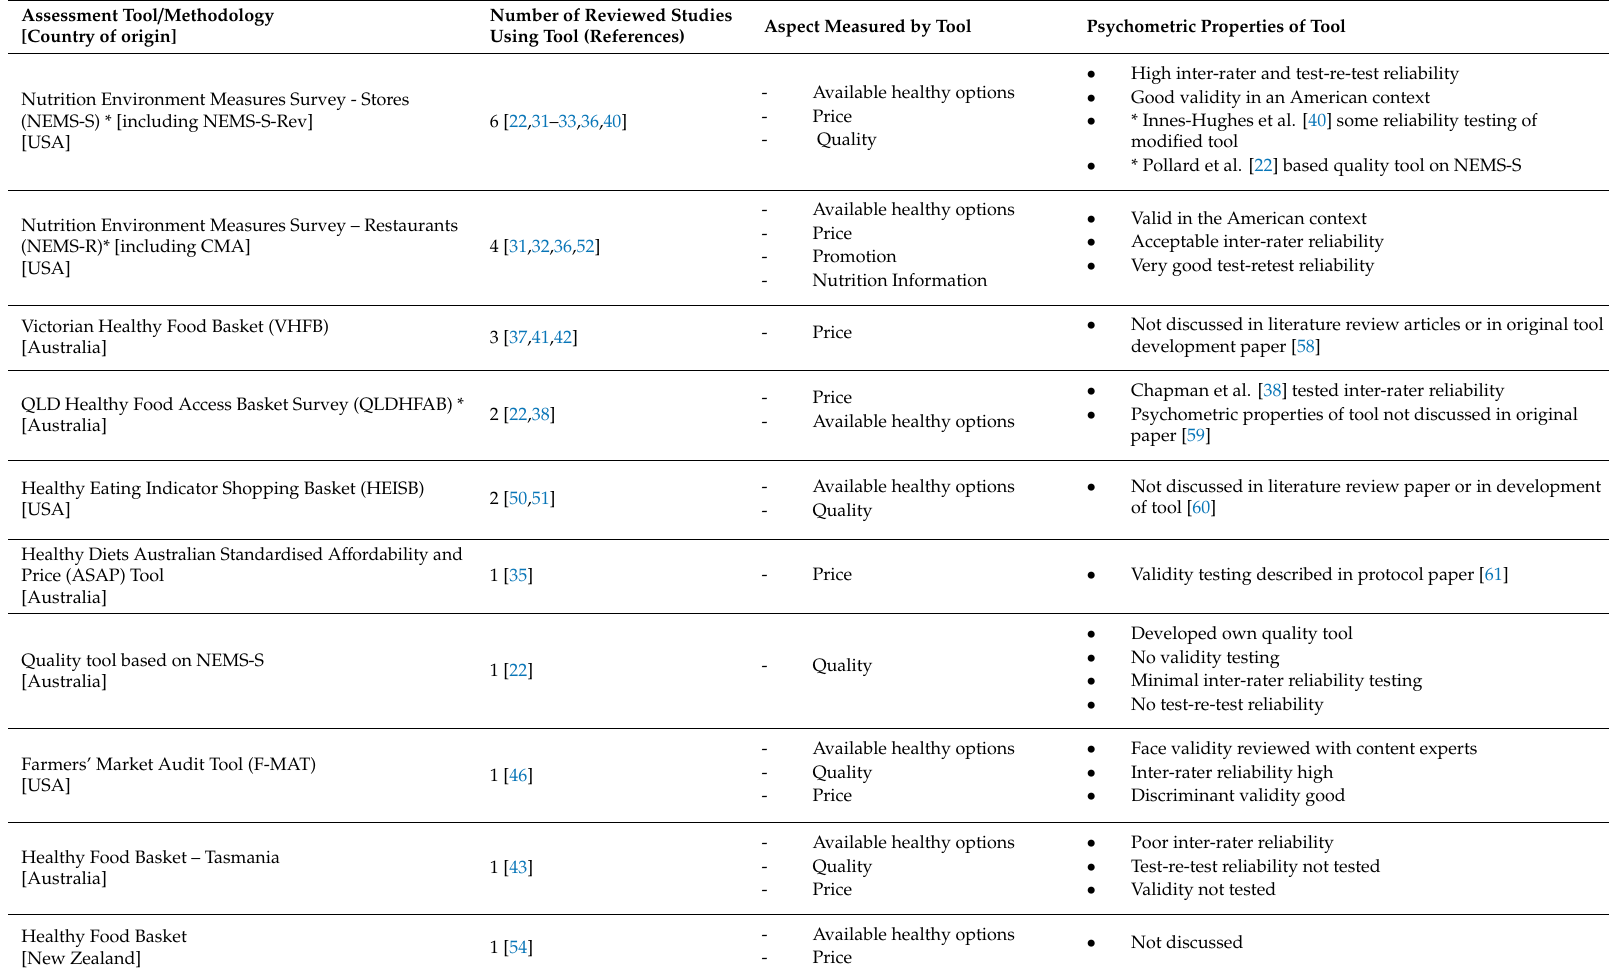
Table 3. Tools measuring the consumer food environment: